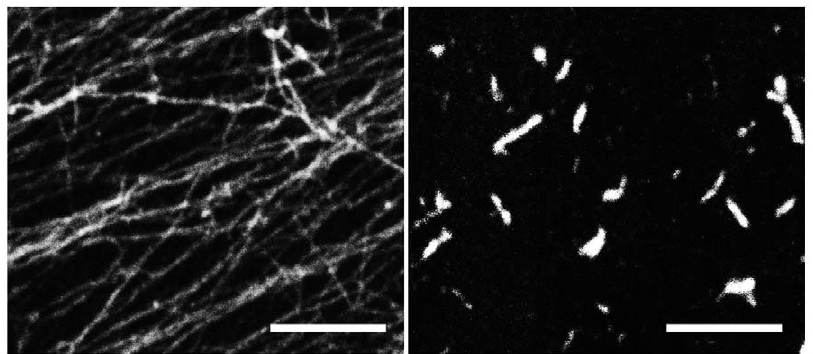
Figure 5. Phalloidin staining of polymerized rabbit actin and ActM. Rabbit actin (left) polymerizes into long filaments forming an interwoven network. ActM polymers (right) appear as short filaments assembling in bundles and sheets. Scale bars: 5 m m.